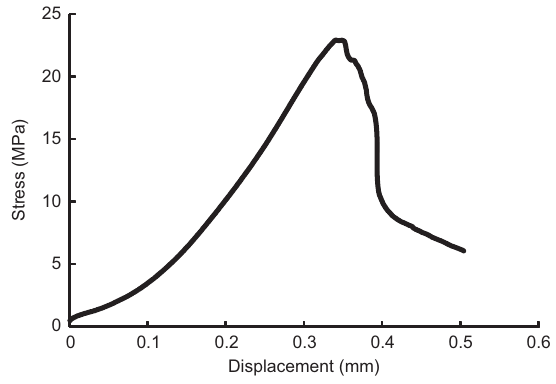
Figure 8 Stress-defl ection curve under shear